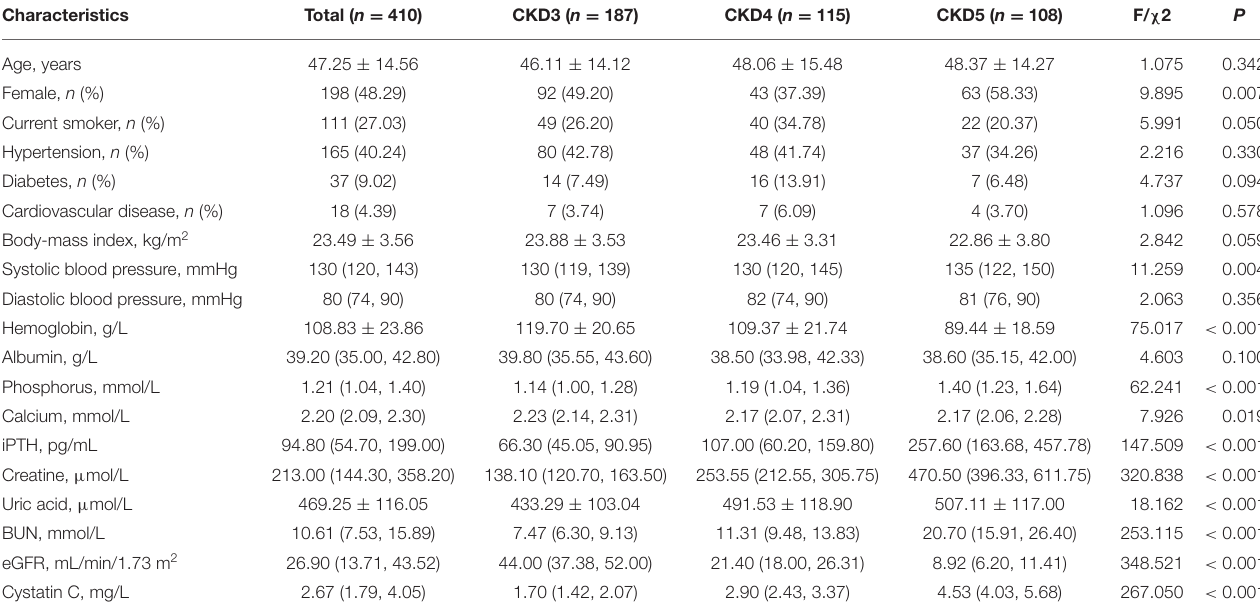
TABLE 1 | The basic characteristics of the included CKD patients.